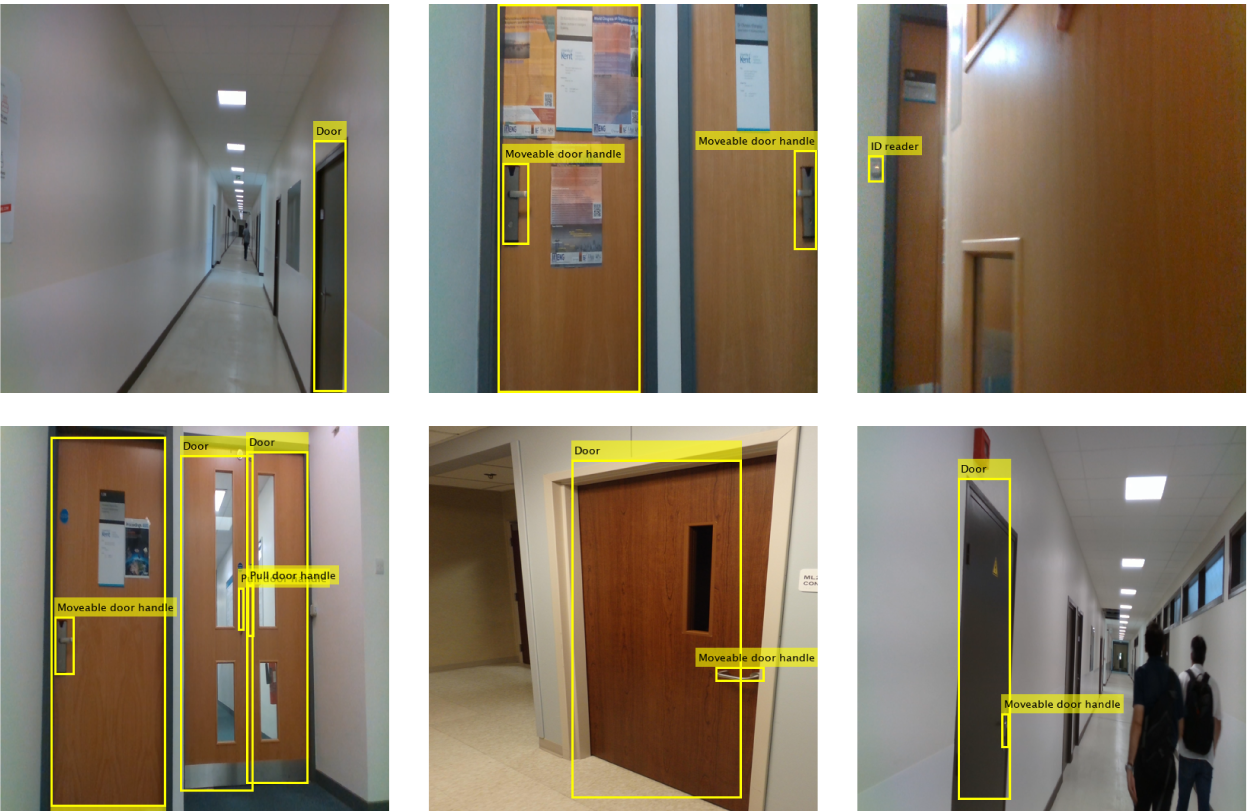
Figure 4. Prediction results of the best performing YOLO V3 detector with three